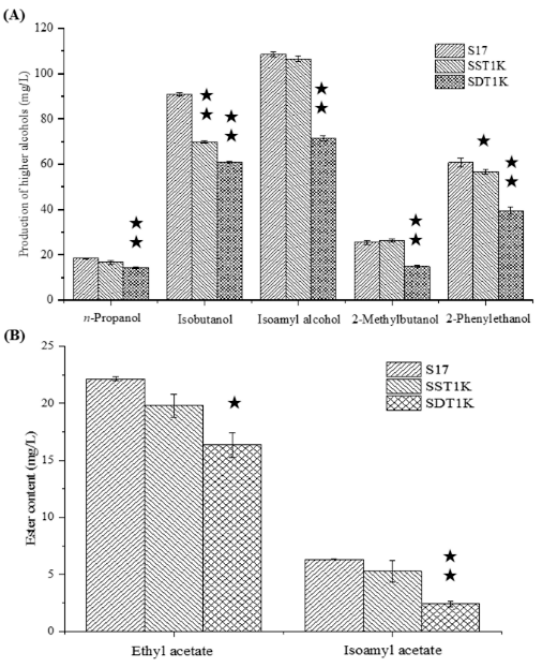
Figure 2. GC analysis results of the samples. ( A ) Higher alcohol production by GAT1 deletion mutants and parental strain S17. ( B ) Esters production by GAT1 deletion mutants and parental strain S17. Data are the averages of three independent experiments. Error bars represent ± SD. ★★ p < 0.01, ★ p < 0.05.